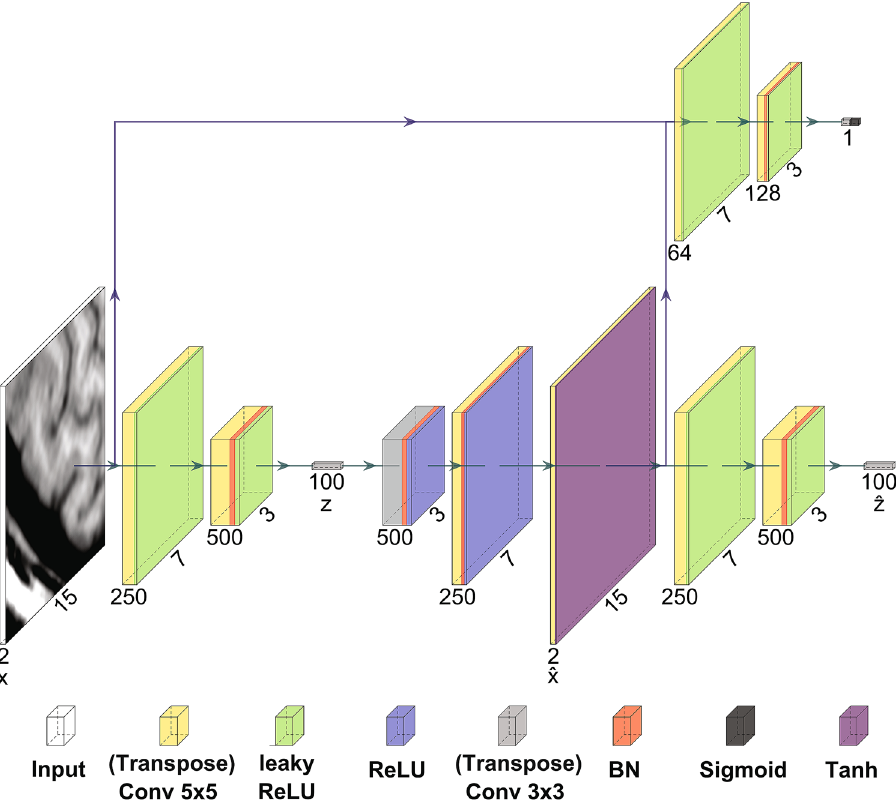
Figure 3. Neural network architecture, visualized using adapted software of PlotNeuralNet 39 . The tensor size after each operation is given by the numbers around each box. The input images are encoded into a latent space z . From the latent space a reconstruction (cid:31) x of the input x is created. A final encoding of (cid:31) x to (cid:31) z is computed. A discriminator, featured in the top of the image, is fed with images x and (cid:31) x , where the output of the first to last layer is used for the calculation of the adversarial loss L adv . Similarly, a reconstruction loss L con is calculated as the mean difference between x and (cid:31) x , and an encoding loss L enc is calculated as the L2 loss between z and (cid:31) z . The (transposed) conv 5 × 5 layers are applied with a stride of 2 and padding of 1, and are in almost all steps followed by batch normalization (BN). The conv 3 × 3 layer is applied with a stride of 1 and padding equal to 0. The leaky rectified linear unit (ReLU) activation has a negative slope equal to